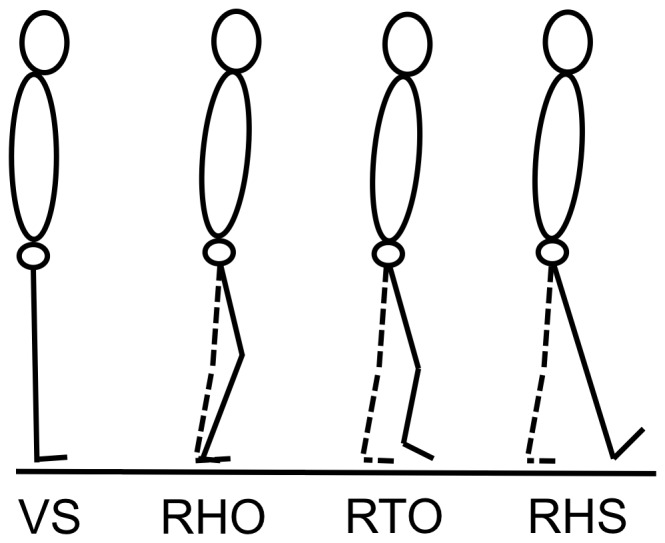
Illustration of the three kinematic events calculated from the appearance of visual signal (VS).The stance lower limb (left) is traced in dashed lines; the swing lower limb (right) is traced in solid lines. RHO: right heel off; RTO: right toe off; RHS: right heel strike.